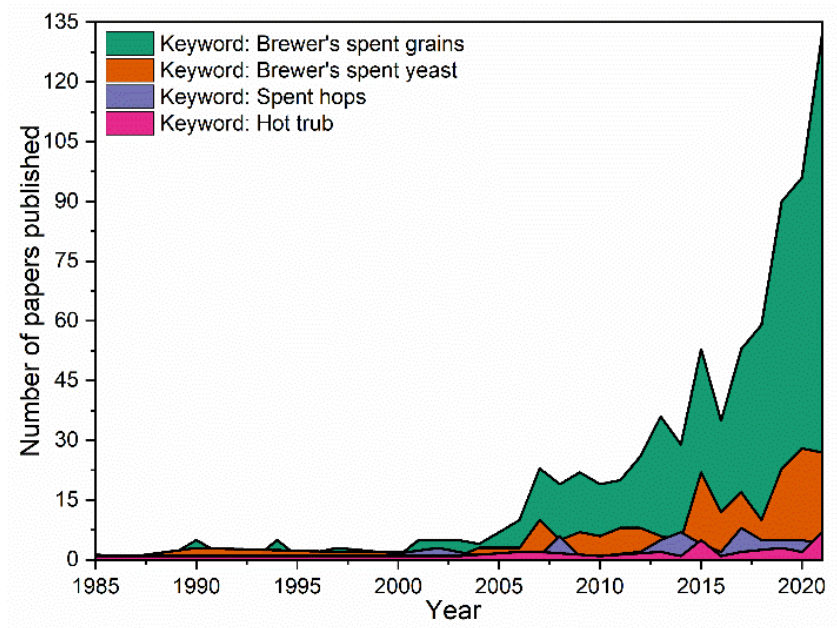
Figure 2. Data acquisition from Scopus databases.